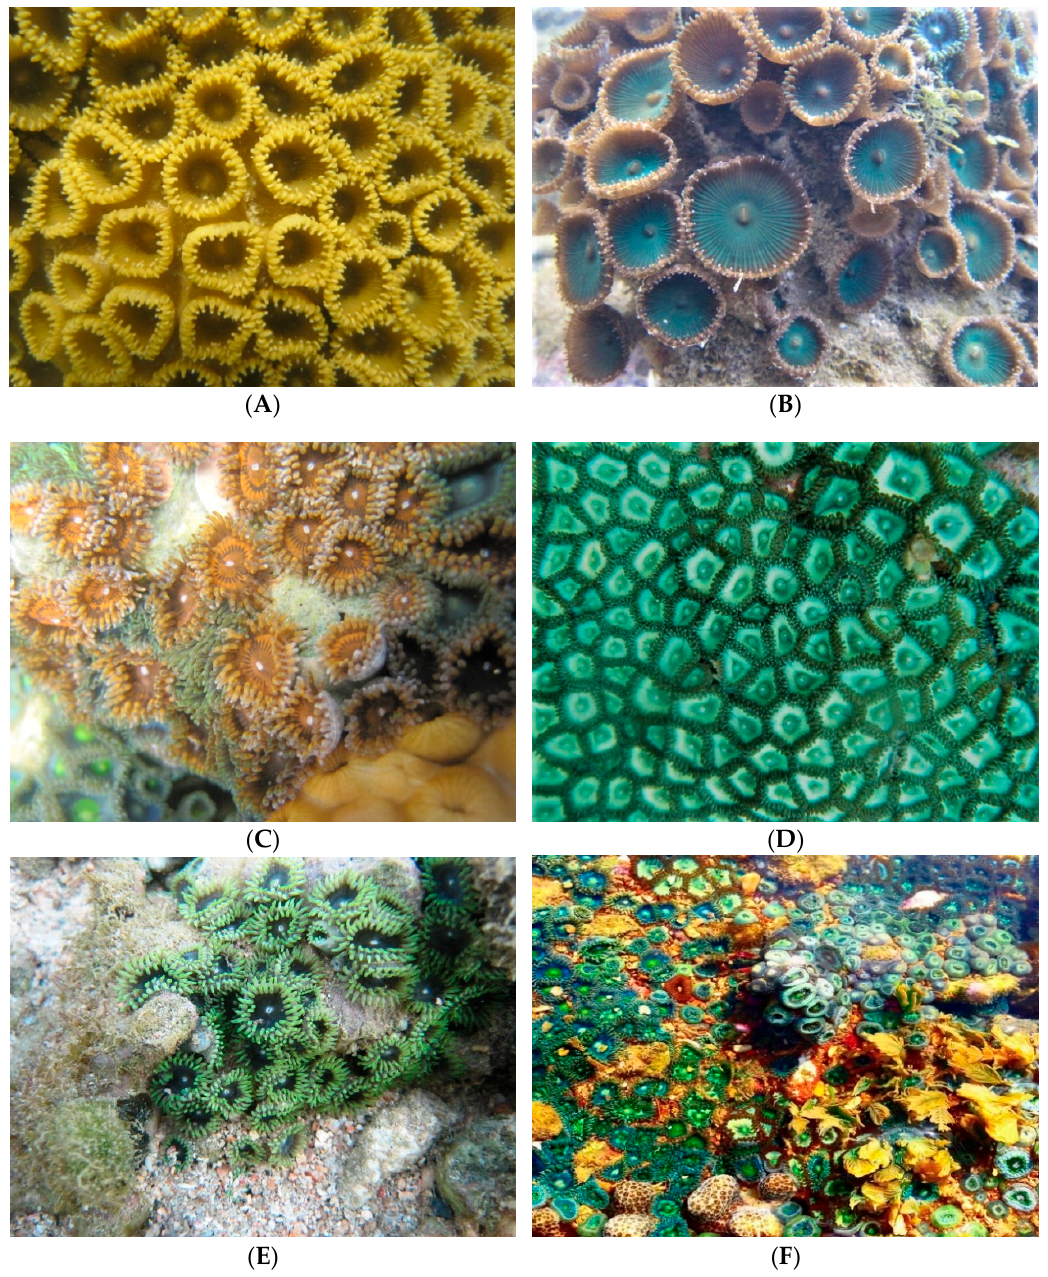
Figure 2. Zoantharian colonies along the northeastern coast of Toco, Trinidad ( A ) brown color morphotype of Palythoa caribaeorum specimen P3-br-SB, ( B ) green color morphotype of Palythoa grandiflora specimen P4-gr-GA, ( C – E ) color morphotype variation in Zoanthus pulchellus specimen Z9-org-GA, Z5-gr-SB, Z6-gr-SB, respectively ( F ) color morphotype in Zoanthus sociatus specimen Z15-blu-GA.